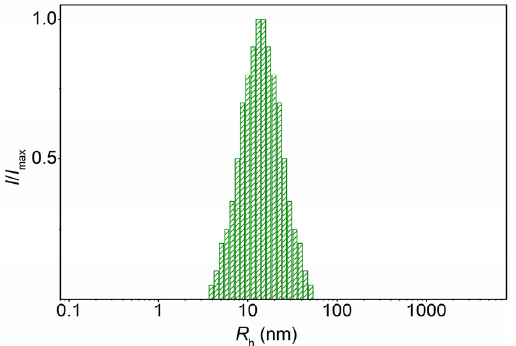
Figure 6. Hydrodynamic radii distribution for solution copolymer APB3 at concentration in ethanol c = 0.0035 g · cm − 3 .